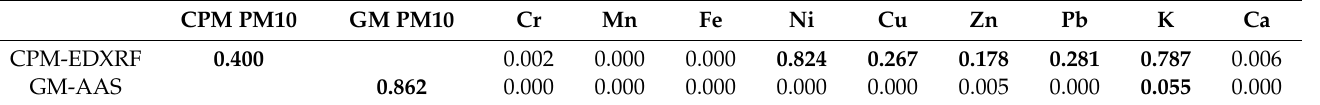
Table 8. EDXRF-AAS p -values of Mann-Whitney U test for season-to-season data. Bold values indicate that the results are significant with p <